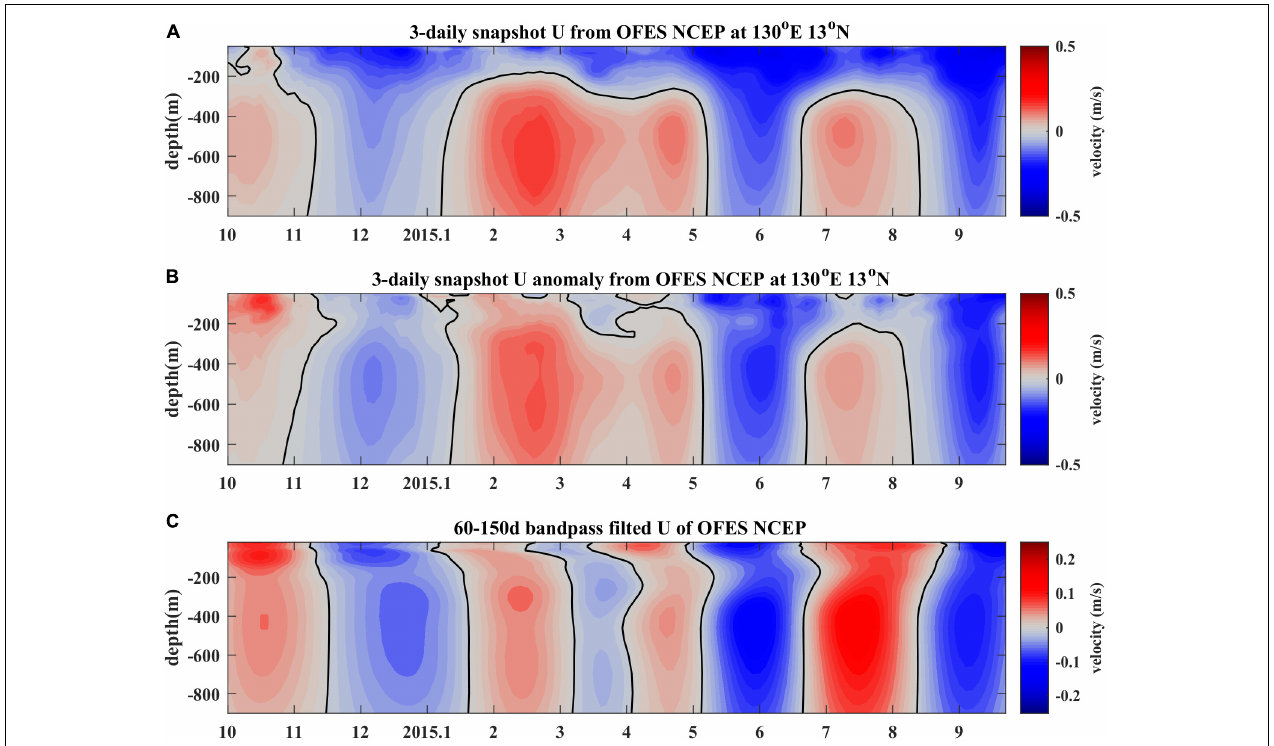
FIGURE 7 | 3-daily snapshot velocities (A) and its anomalies (B) at 13 ◦ N, 130 ◦ E from OFES outputs. (C) is the same as (B) but after a 60–150 day band-pass